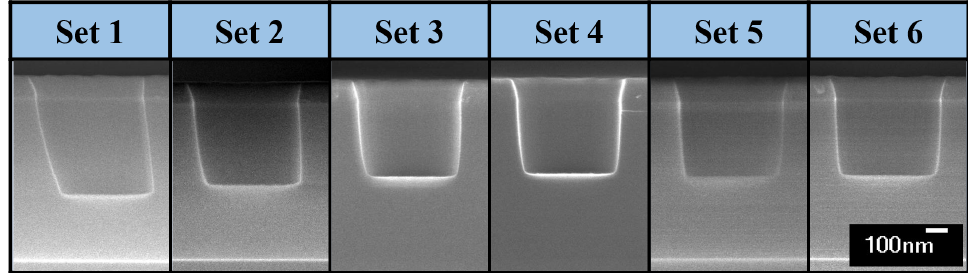
Figure 4. Cross-sectional SEM images of 650 nm contact holes each set point and in 3.0 mm wafer